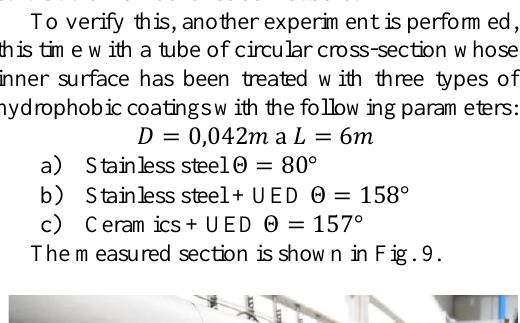
Fig. 10 The dependence of specific energy on Reynolds